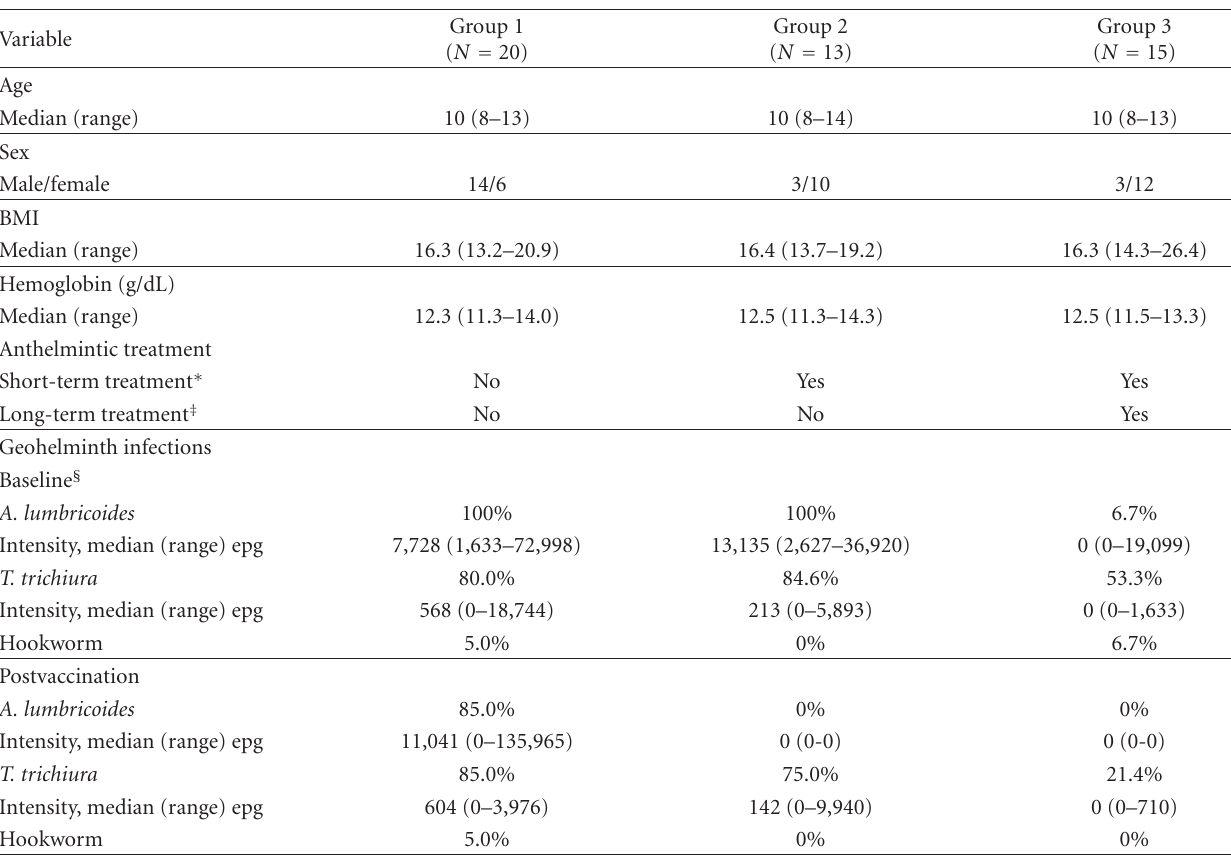
Table 1: Baseline characteristics of study children. Group 1: active infection with A. lumbricoides ; Group 2: short-term anthelmintic treatment; Group 3: long-term anthelmintic treatment. BMI-body mass index. ∗ 2 doses of 400 mg albendazole over 1 month. ‡ 7